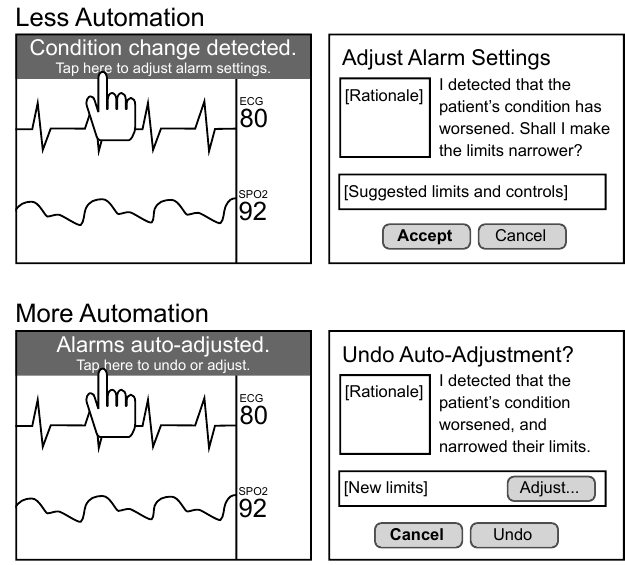
Figure 6. Two alternate designs that could be implemented to handle changes in patient acuity. In the top story, the monitor prompts the nurse to change the alarm limits, and then suggests new limits, which the nurse may modify. In the bottom story, the monitor changes the limits automatically, then allows the nurse to undo this, adjust the limits manually, or accept the new limits. We discuss options for the rationale that will appear in the “Rationale” panels in Section